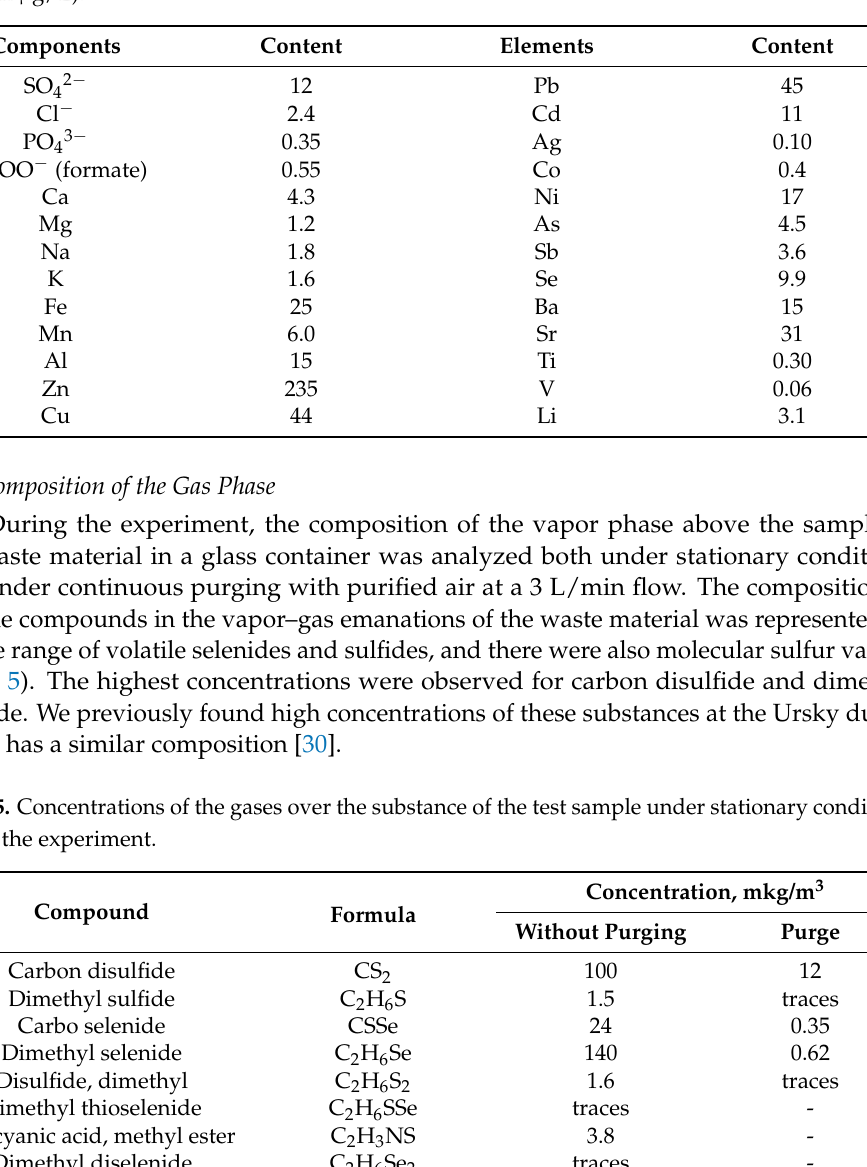
Table 4. Composition of the condensate collected in a laboratory experiment (SO 42 − –K in mg/L, Fe–Li in µ g/L).